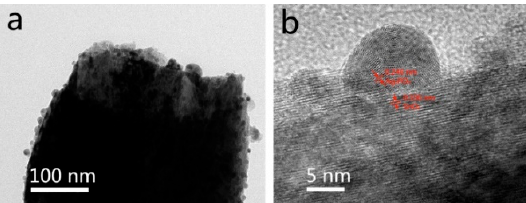
Figure 4. TEM image of Ag 3 PO 4 / SnO 2 / CC ( a ). HRTEM image of Ag 3 PO 4 / SnO 2 / CC ( b ).